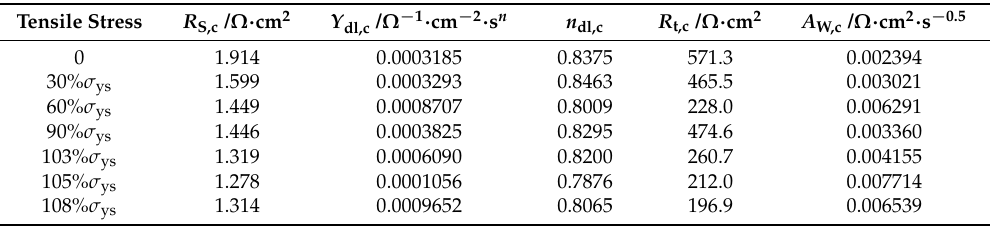
Table 5. EIS parameters of X80 steel obtained by fitting the EIS curves of X80 steel measured at − 60 mV (vs. OCP) in 3.5 wt% NaCl aqueous solution with saturated CO 2 under different elastic and plastic tensile stress at 30 °C.